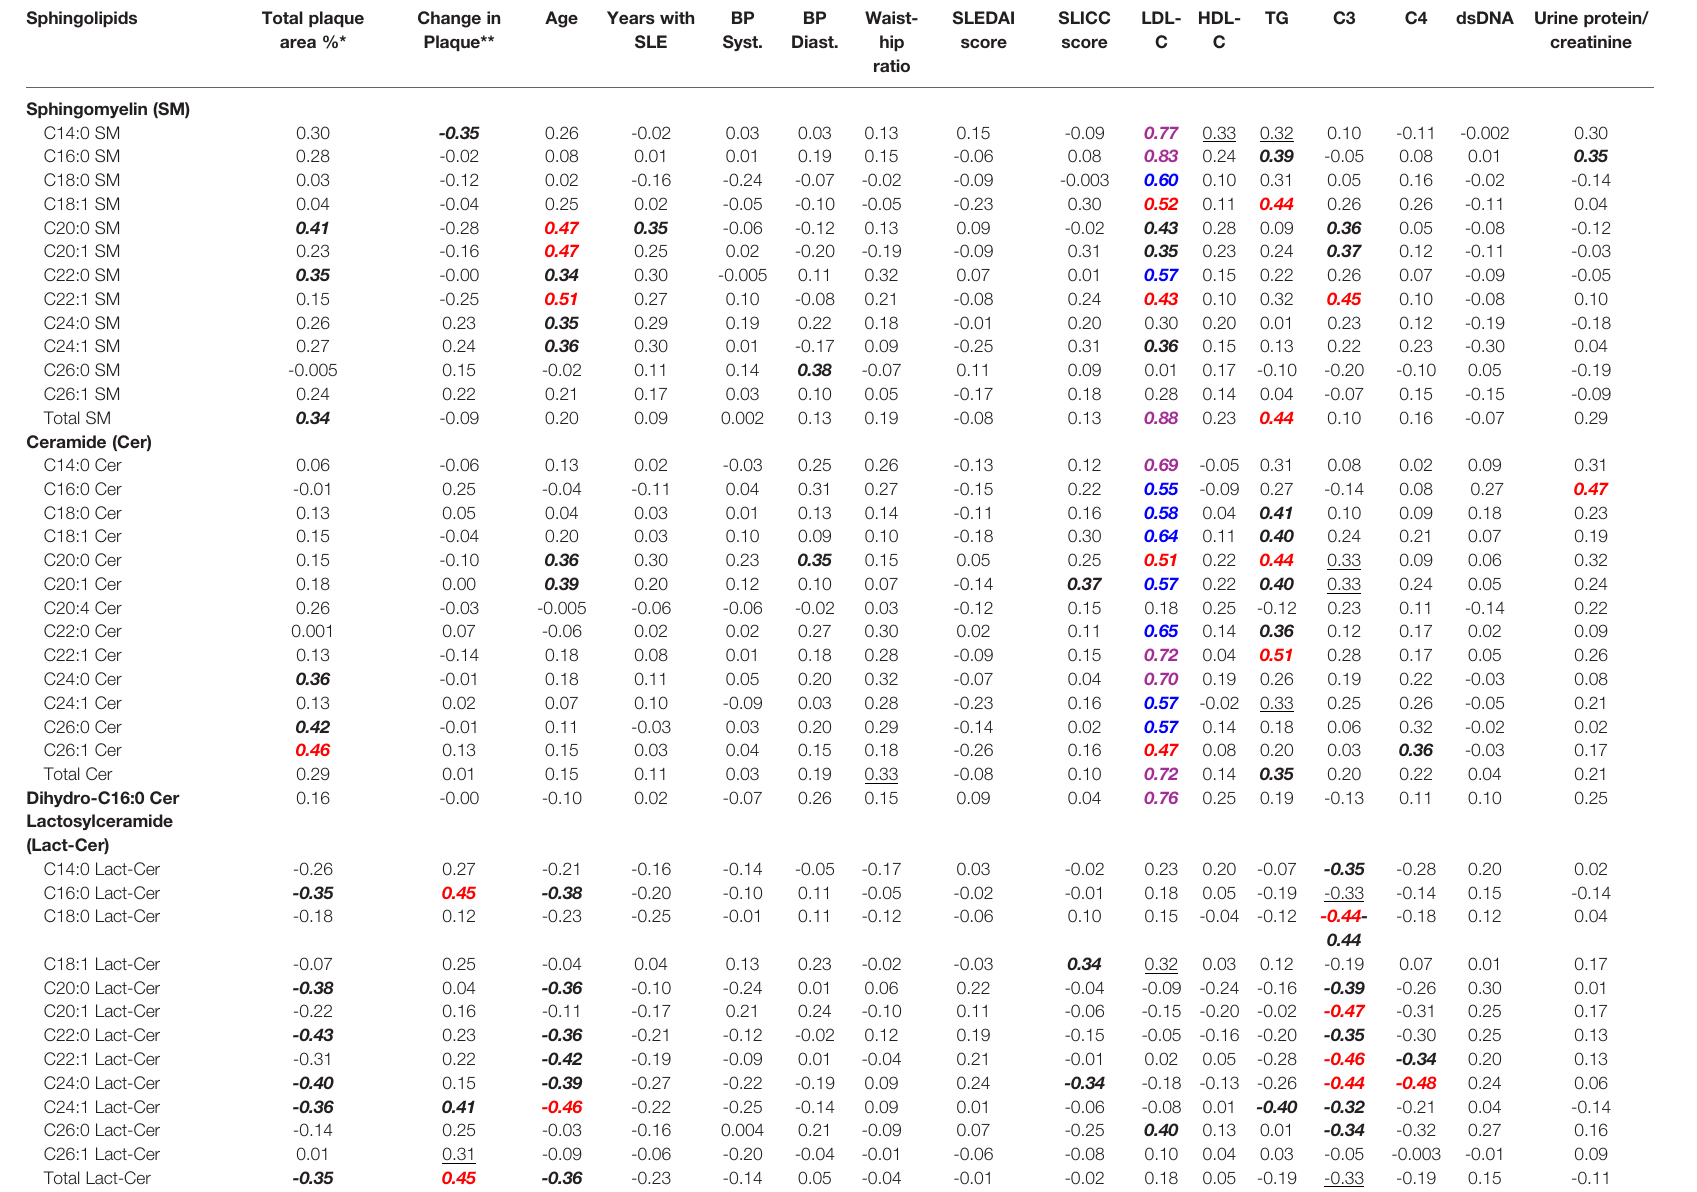
TABLE 3 | Correlations between plasma sphingolipids and clinical variables, including baseline (visit 1) plaque area and change in plaque at visit 2.